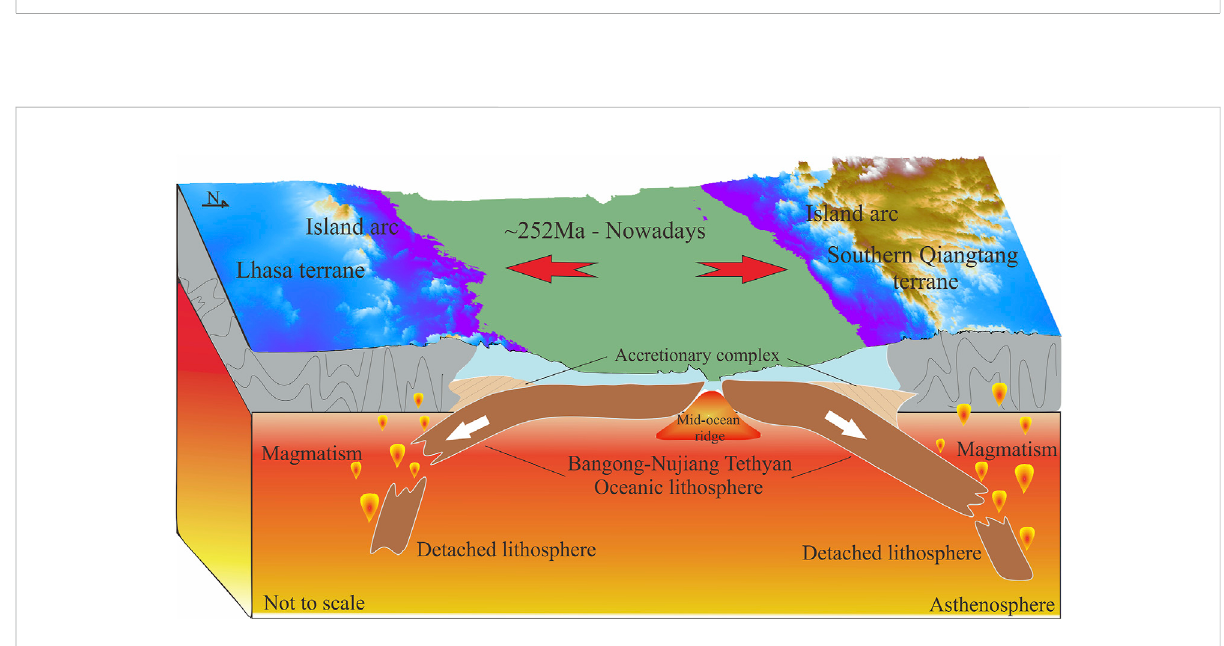
FIGURE 8 Cartoon of the bidirectional subduction of the Bangong-Nujiang Tethyan Ocean; Subduction-related accretionary complex, island arc and magmatism are also drawn.